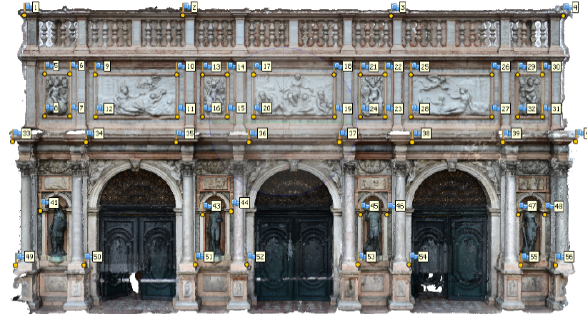
Figure 13. Mesh of the 2021 photogrammetric model The comparison shows a resulting scalar field according to a range that varies from -0.5 to 0.5 m, to exclude from the comparison all the points that do not belong to the surface of the facade (in this case the blue> green> yellow> red scale was used).